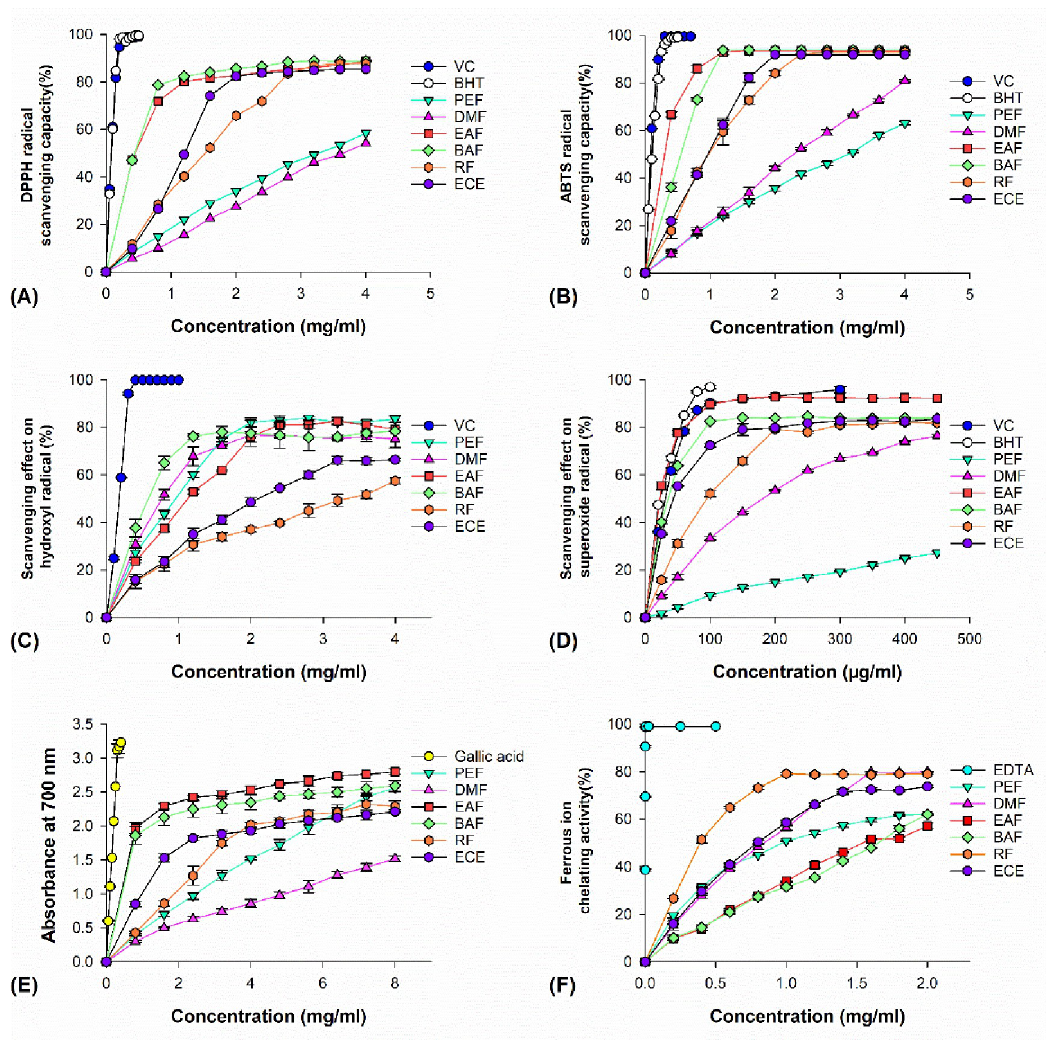
Fig 2. The antioxidant and free-radical scavenging activities of the extracts and fractions of C . cyrtophyllum leaves evaluated by using six in vitro antioxidant models, namely, the (A) DPPH � , (B) ABTS � , (C) OH � , and (D) O 2 � - radical scavenging activities as well as the (E) reducing power and (F) iron-chelating capacity. ECE, ethanolic crude extract; PEF, petroleum ether fraction; EAF, ethyl acetate fraction; BAF, n -butyl alcohol fraction; RF, remaining fraction. Responses are the means ± SD (n = 3)